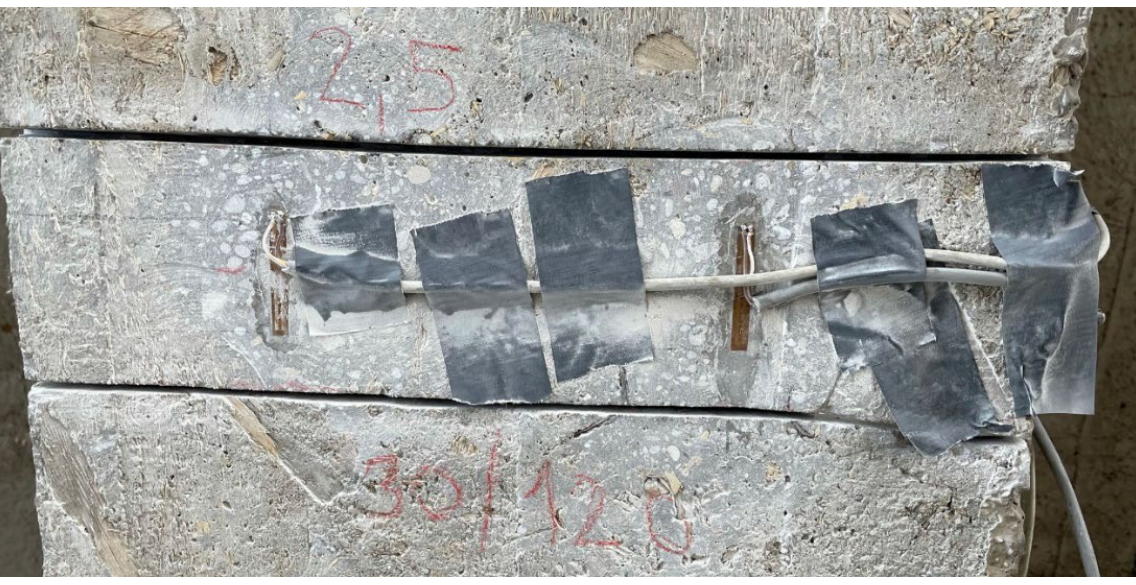
Figure 10. View on performed saw-cuts and installed strain gauges.